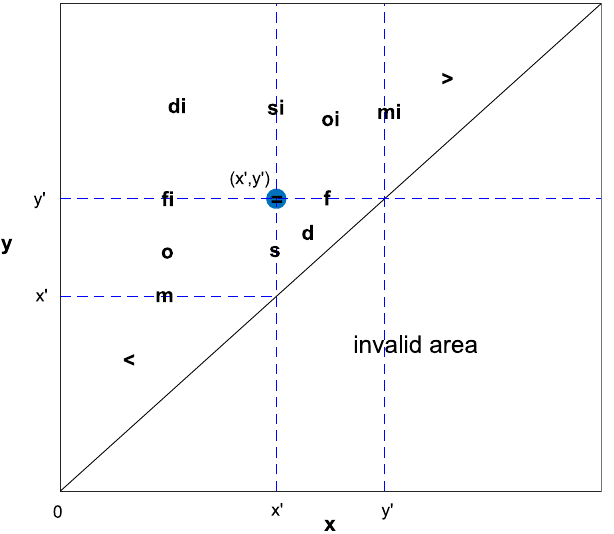
Figure 2. If an interval is associated with a 2-dimensional point, an interval query can be transformed to a range query. The query interval [ x ′ , y ′ ] is associated with the point ( x ′ , y ′ ), and the interval query regarding each of Allen’s interval relations corresponds to the range query regarding the indicated area (marked in the figure by the corresponding relation symbol, the “ = ” query exactly corresponds to the point ( x ′ , y ′ )). The start is less than or equal to the end for an interval, thus, points in the lower right area under the line y = x is invalid to associate an interval